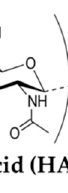
Figure 11. The structure of hyaluronic